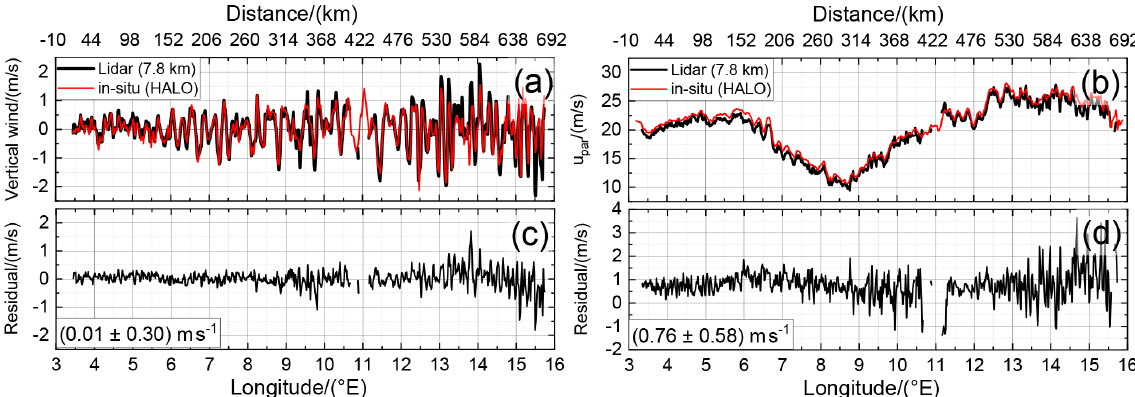
Figure 6. Vertical wind speed (a) and horizontal wind speed along flight direction (b) derived from 2µmDWL observations acquired in MF mode on FL3 at 7.8km altitude (black), and the wind speed measured in situ at the HALO aircraft flying at the same altitude (red). The bottom panels (c) and (d) indicate the corresponding residuals.